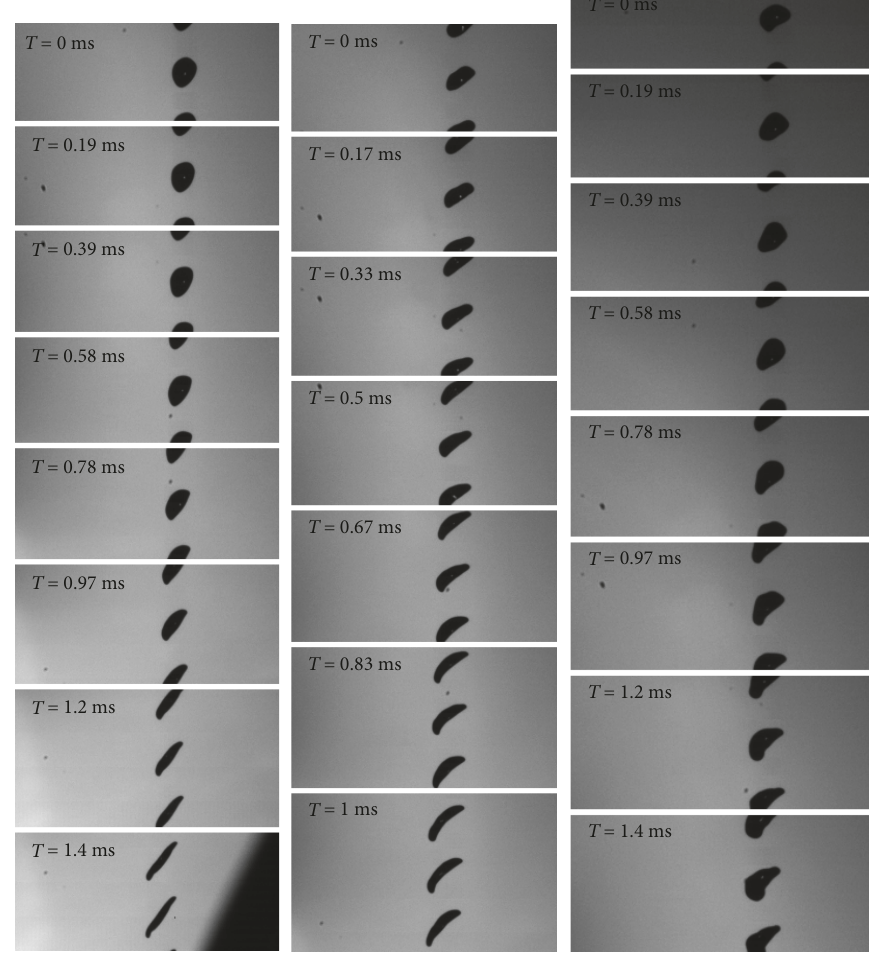
Figure 12: Recorded droplet evolution for cases #1 (left), #2 (centre), and #3